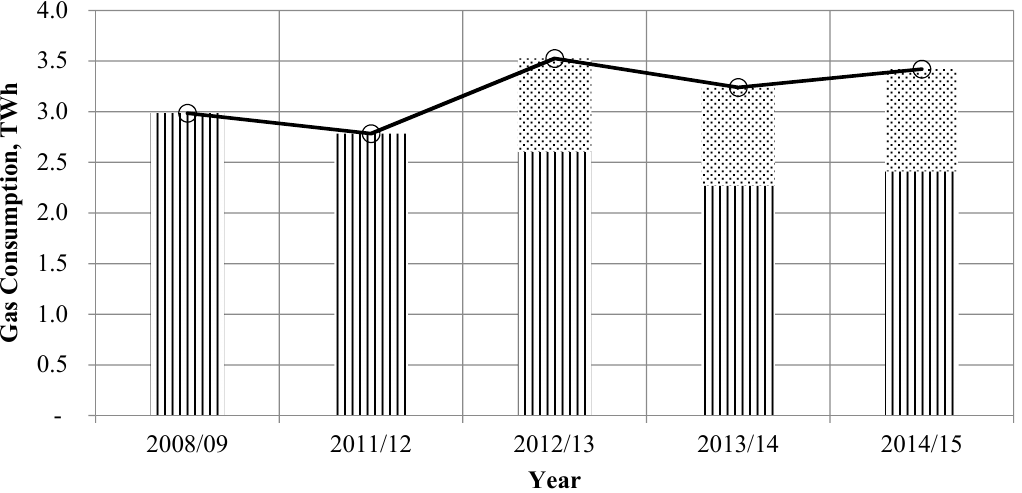
Figure 3. Variation of annual gas consumption of England’s HE sector [4].